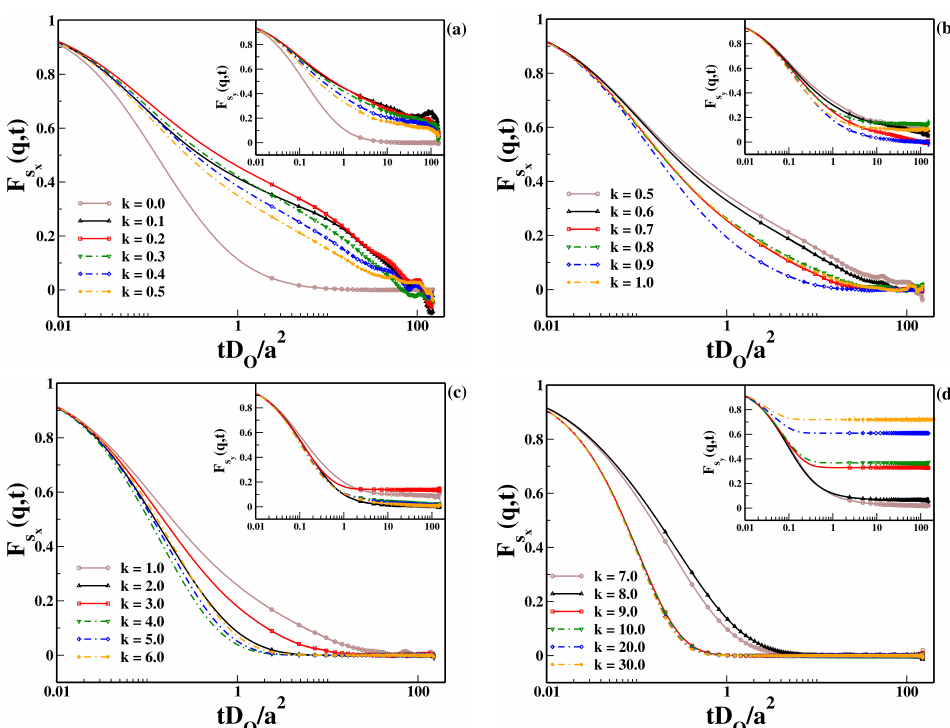
Figure 9. Self-intermediate scattering functions F s ( q = π , t ) as a function of the trap stiffness, going from ( a ) and ( b ) weak to ( c ) intermediate and ( d ) strong couplings. The main figure shows the sIFS along the non-confinement direction, and the inset displays the sIFS in the y